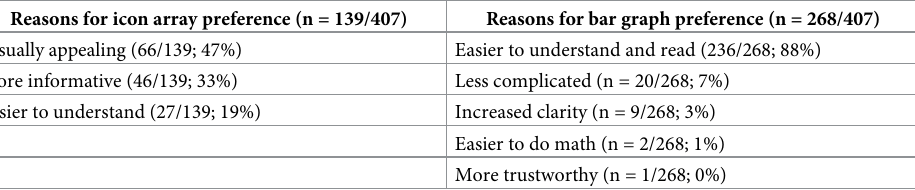
Table 4. Rationale provided by users as to why they prefer the bar graph or the icon